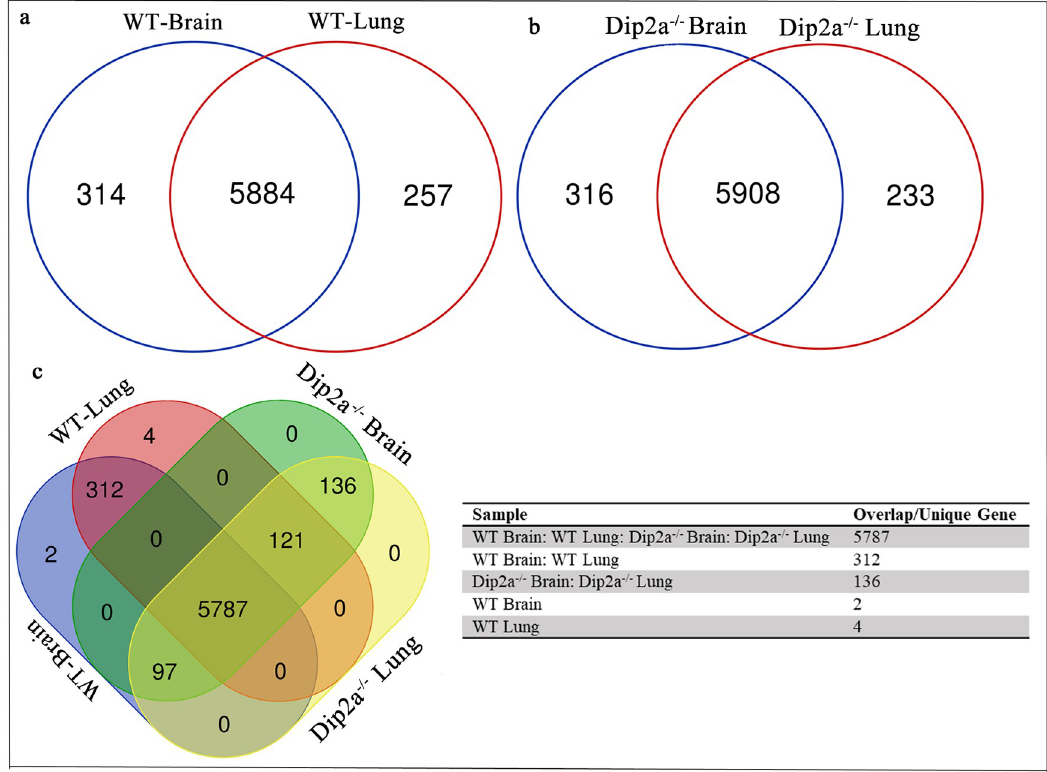
Fig 1. Venn diagrams showing overlap and unique unigenes identified within Wild type (WT) brain, Wild type (WT) lung, Dip2a -/- brain and Dip2a -/- lung. (a) In WT group, total 5884 genes were expressed in both samples, 314 genes unique to brain and 257 genes unique to lung (b) In Dip2a -/- group, total 5908 genes were expressed in both samples, 319genes were unique to brain and 233 unigenes were unique to lung. (C) 5787 genes were expression in all samples, 2 genes were unique to WT brain and 4 genes were unique to WT lung.